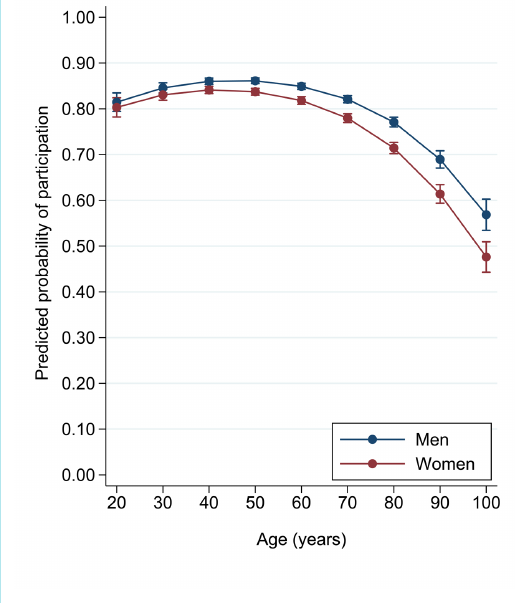
Figure 1: Predicted probability of participation by sex at spe- cific age levels. Dots represent the predicted probability of partici- pation by sex at specific age levels (20 years, 30 years, etc.) gen- erated from a multiple logistic regression model in which the outcome was participation (code is 1 for a participant and 0 for a non-participant) and which included consent place, citizenship, re- ligion and marital status as covariates. The whiskers represent 95% confidence intervals. The age-specific estimated probabilities of participation are depicted in blue for men and in red for